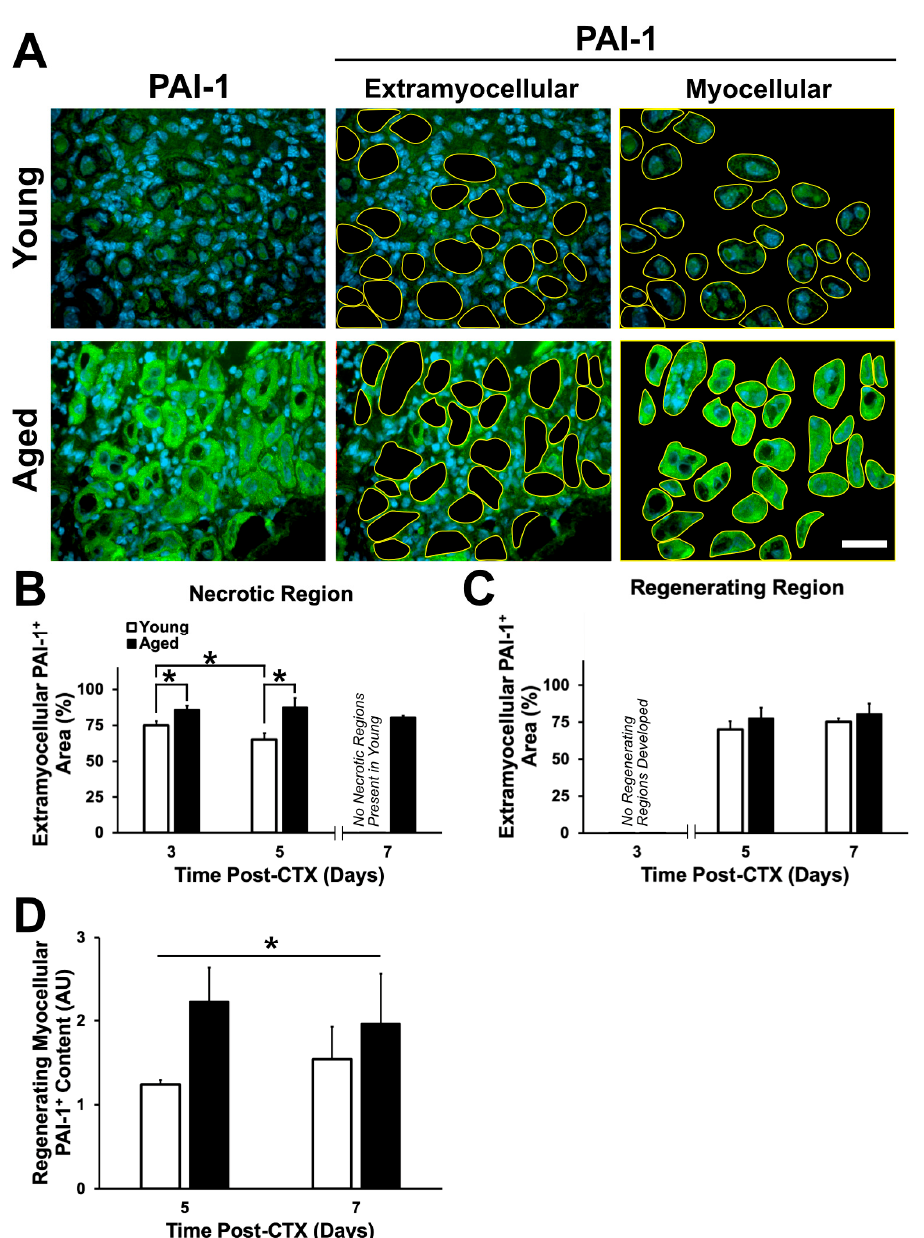
Figure 9. PAI-1 expression is greater in aged skeletal muscle. ( A ) Immunostaining of PAI-1 (green) and DAPI (blue) at five days following damage. ( B ) A significant interaction between age and recovery time point following damage was observed in the necrotic regions ( p = 0.044). Simple main e ff ect post-hoc analyses demonstrated a significant greater extramyocellular PAI-1 expression within aged muscle at three and five days following damage ( p = 0.005 and p < 0.001, respectively). Extramyocellular PAI-1 within the necrotic regions of young muscle declined significantly between three and five days following damage ( p = 0.015). * denotes significant differences between groups identified by the simple main effects post-hoc analyses ( p < 0.05). ( C ) No significant differences in extramyocellular PAI-1 were observed in the regenerating region of young and aged muscle ( p > 0.05). ( D ) Brightness analysis of PAI-1 within regenerating myofibers showed significantly greater PAI-1 signal within aged regenerating myofibers compared to young (* denotes main e ff ect of age: p = 0.029). n = 4–5 per group. Data presented are means ± standard deviation. Scale bar represents 50 µ